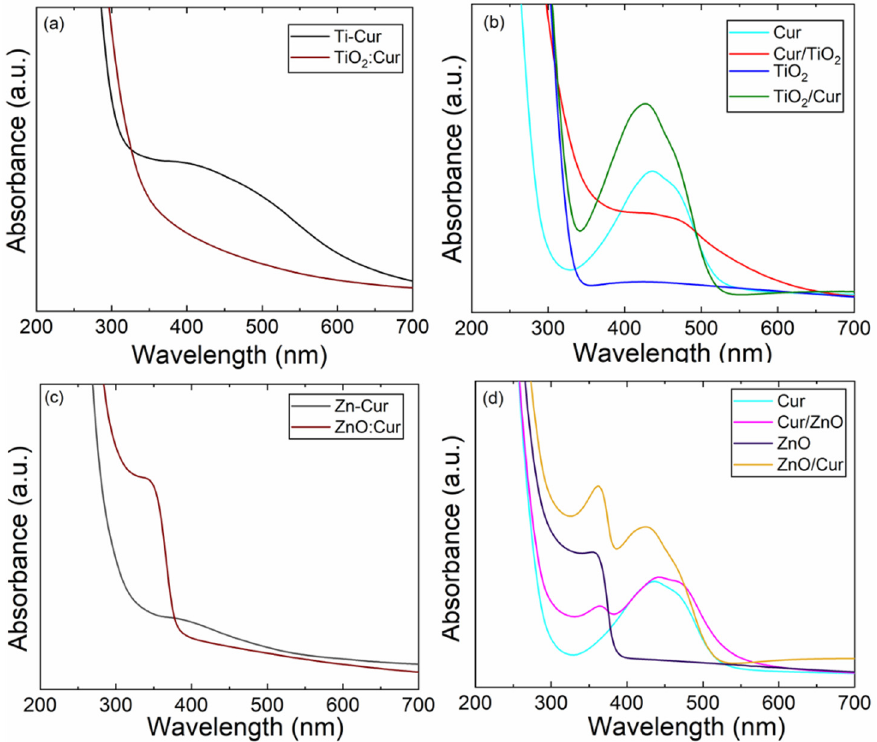
Figure 6. UV-vis absorption spectra for representative thin-film samples: ( a ) Ti-Cur and TiO 2 :Cur SL ( n = 5), ( b ) Cur and TiO 2 , and their DL combinations, Cur/TiO 2 and TiO 2 /Cur ( c ) Zn-Cur and ZnO:Cur SL ( n = 5), ( d ) Cur and ZnO, and their DL combinations, Cur/ZnO and ZnO/Cur.